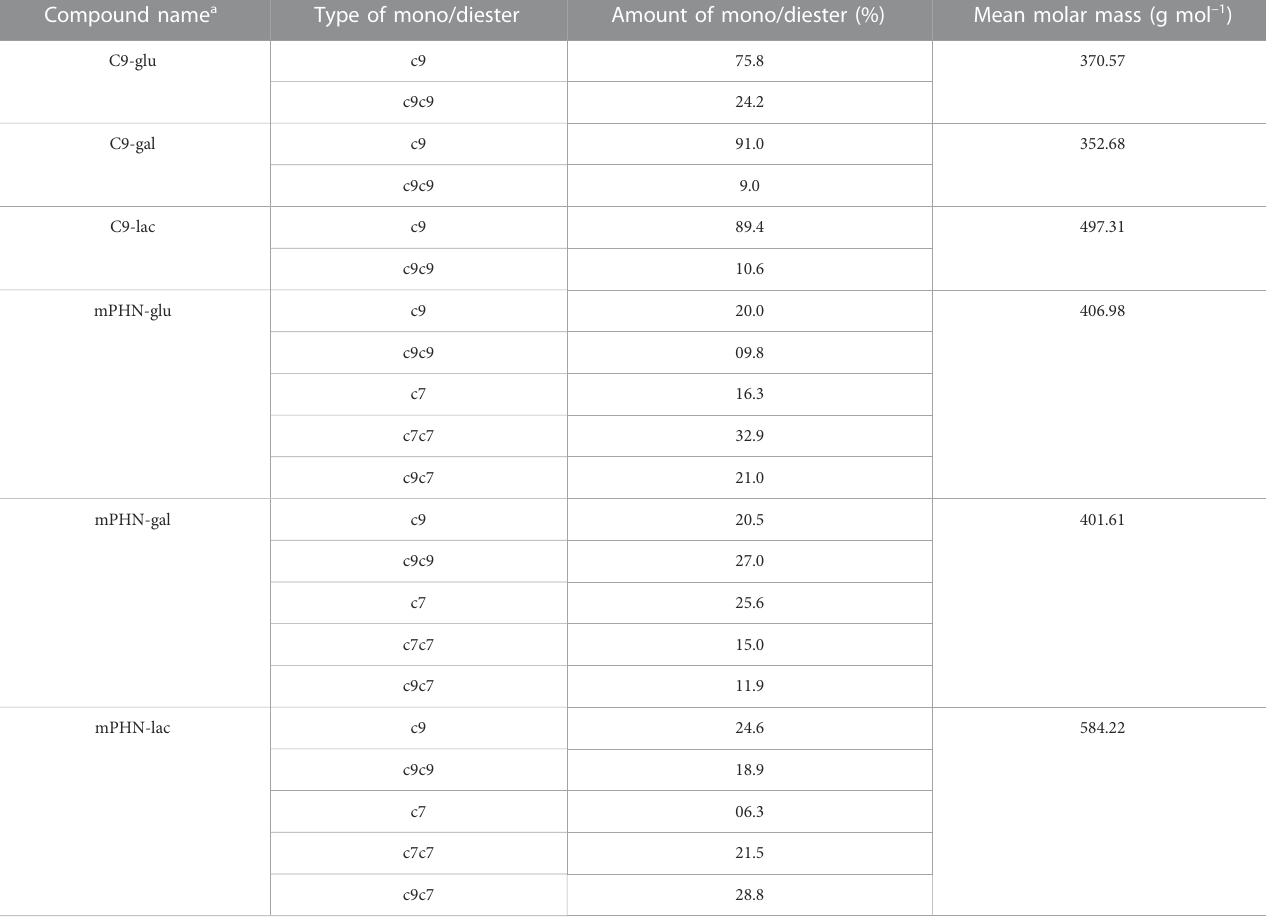
TABLE 1 Composition of enzymatically obtained sugar esters used in this work. Compound name